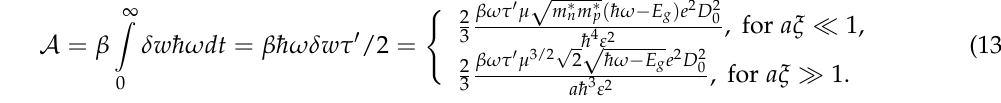
Table 3. Substrate material parameters to Formula (17) ( m = 9.1